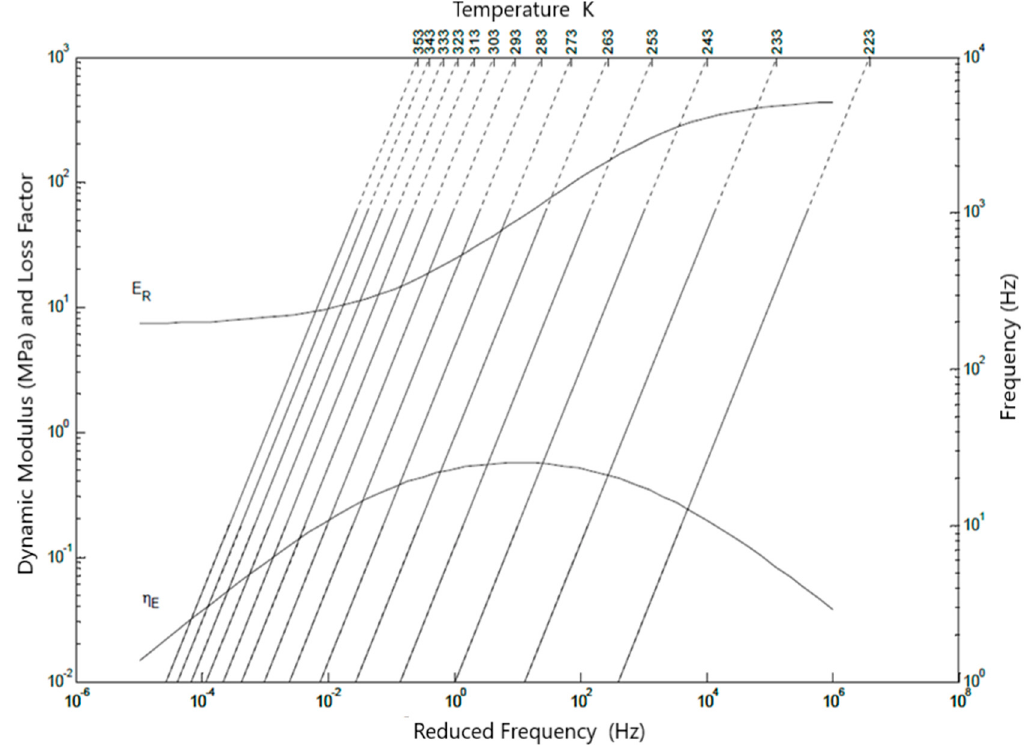
Figure 6. Reduced frequency nomogram for Butyl Rubber. E 0 = 7.21 × 10 6 Pa, E ∞ = 4.57 × 10 6 Pa, β = 0.417, b 0 = 0.0223 and T 0 = 243 K .